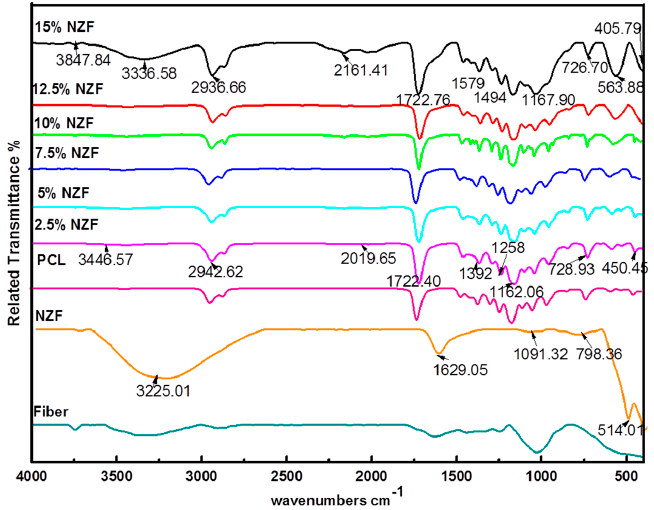
Figure 2. FTIR spectra of OPEFB fibres, NZF, polycaprolactone (PCL) and NZF + OPEFB + PCL for different percentages of NZF filler in the composites.